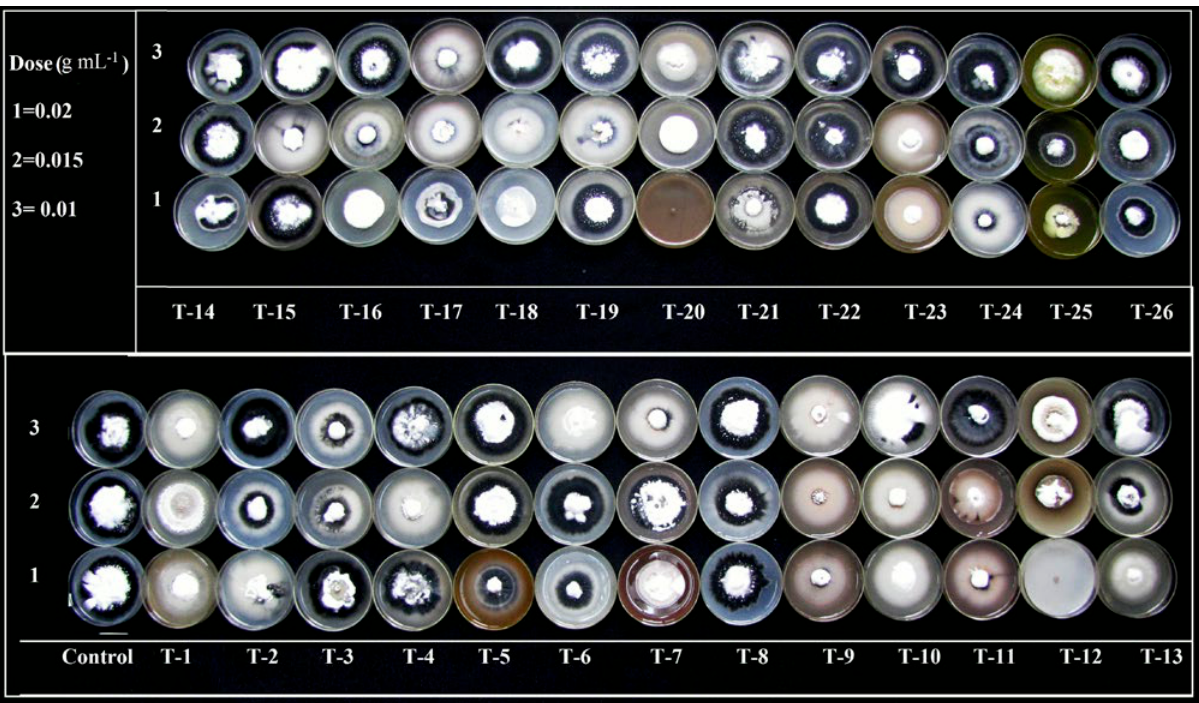
Figure 2. Performance of extracts from different Chinese medicinal herbs (see Table 1) on inhibition mycelial colony growth of Verticillium dahliae under in vitro